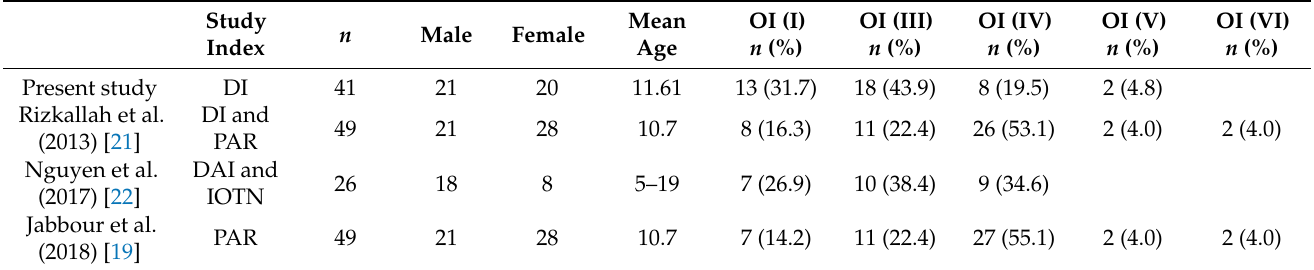
Table 5. Characteristics of the study population: mean age, sex and type of Osteogenesis Imperfecta. Comparison with other studies. DI (Discrepance Index); PAR (Peer Assessment Rating); DAI (Dental Aesthetic Index); IOTN (Index of Orthodontic Treatment